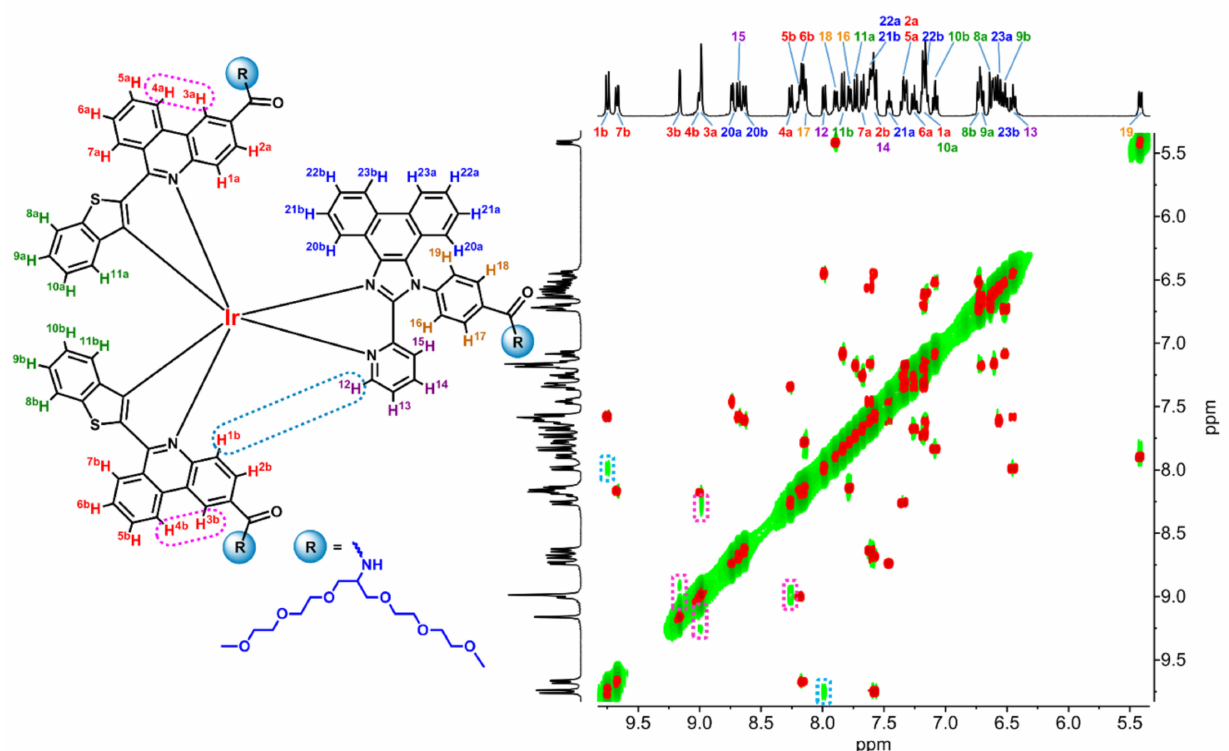
Figure 1. 1 H- 1 H COSY and NOESY NMR spectra of Ir1 , CD 3 OD, 323 K. Red diagonal and cross-peaks are related to the COSY spectrum, green diagonal and cross-peaks are from the NOESY spectrum. Pairs of protons generating NOESY cross-peaks, which do not coincide with the COSY signals, are circled with colored dashed lines both in the spectrum and in the structural pattern.